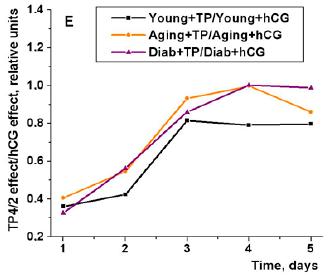
Figure 3. The effects of five-day treatment of the young adult, aging and diabetic male rats with TP4/2 and hCG on the blood testosterone levels. ( A ) Young+dmso—young adult rats plus DMSO, i.p.; Young+TP—young adult rats plus TP4/2, 20 mg/kg, i.p.; Young+saline—young adult rats plus saline,